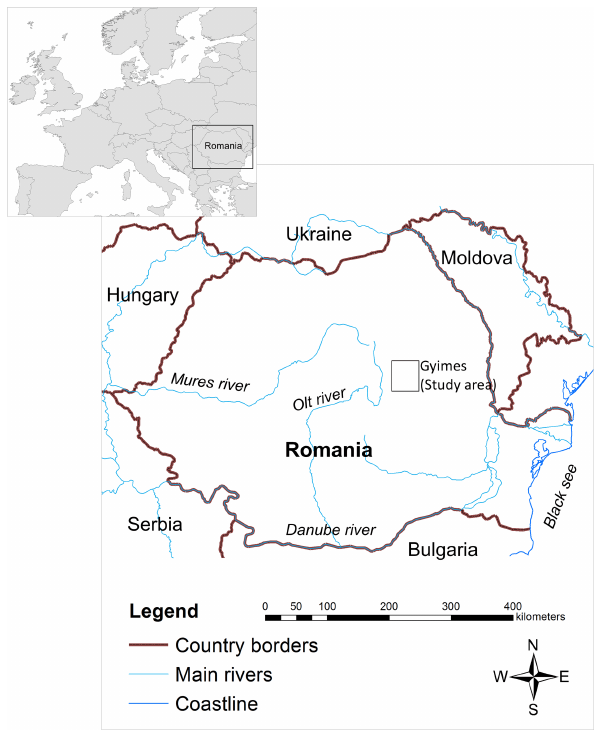
Fig. 1 . The geographical location of the study area in the Eastern Carpathians, Romania. Maps were prepared using ArcGIS.10.1 (ESRI), Natural Earth open layers (https://www.